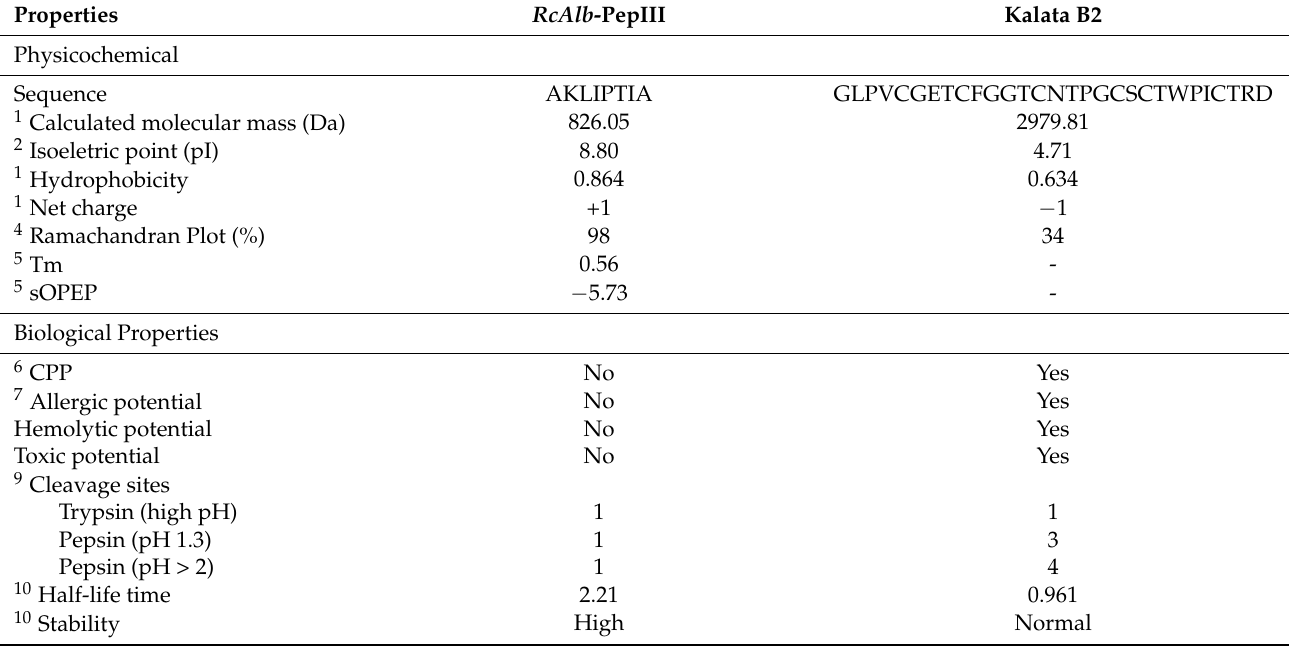
Table 1. Physicochemical characterization and in silico analysis of synthetic peptide RcAlb